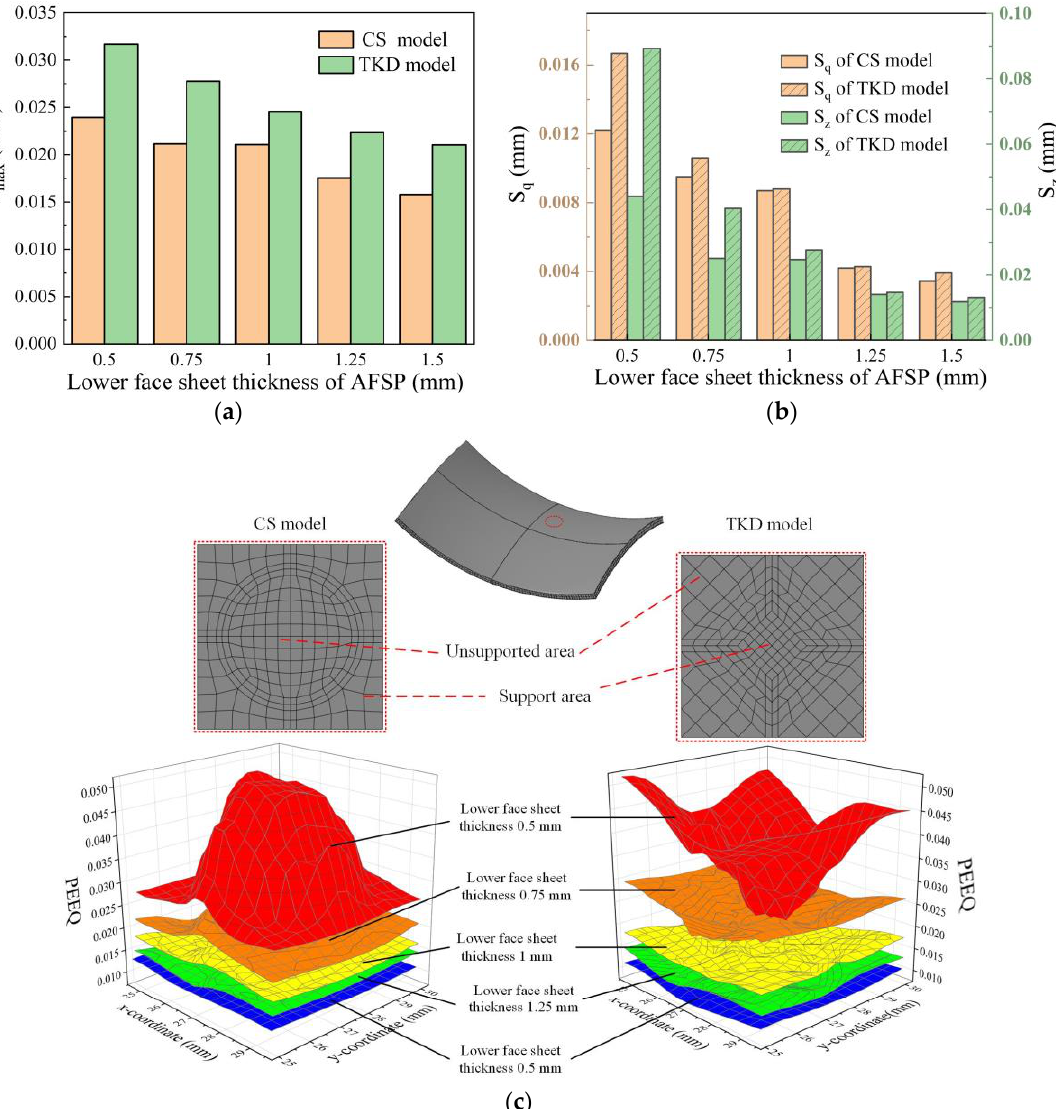
Figure 13. ( a ) d max with different lower face sheet thickness of spherical AFSP ( b ) S q and S z with different lower face sheet thickness of saddle-shaped AFSP ( c ) Equivalent strain of lower face sheet of saddle-shaped AFSP with different thickness.